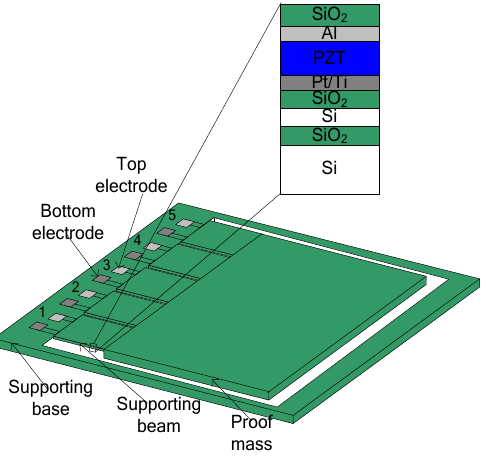
Figure 1. Cross section structure of MEMS piezoelectric cantilever array.